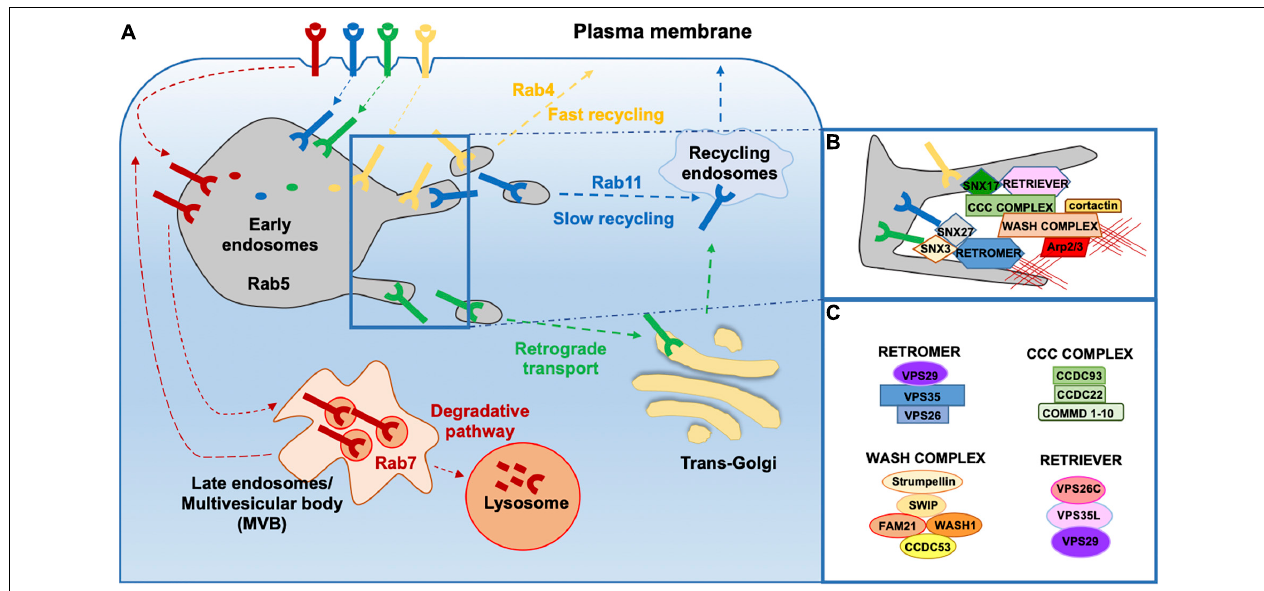
FIGURE 1 | Overview of endosomal sorting and associated molecular machineries. (A) Following internalization, transmembrane proteins can be delivered to the degradative pathway through late endosomes and finally lysosomes or can be destined for recycling. Delivery of cargo back to the cell surface can occur directly through the fast recycling pathway or indirectly through the slow recycling pathway involving the pericentrosomal recycling compartment. Some cargo proteins can undergo retrograde transport from endosome to the Trans Golgi Network (TGN). (B,C) Multiprotein complexes involved in the retrieval and recycling of cargo proteins on (B) endosomes and the (C) components of each